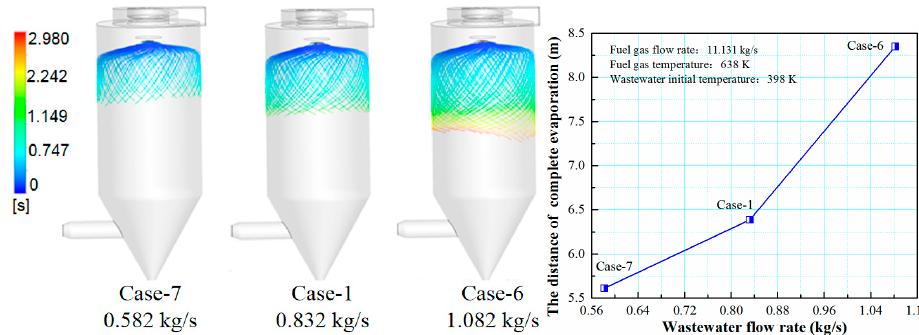
Figure 12. Effect of wastewater flow rate on evaporation performance.